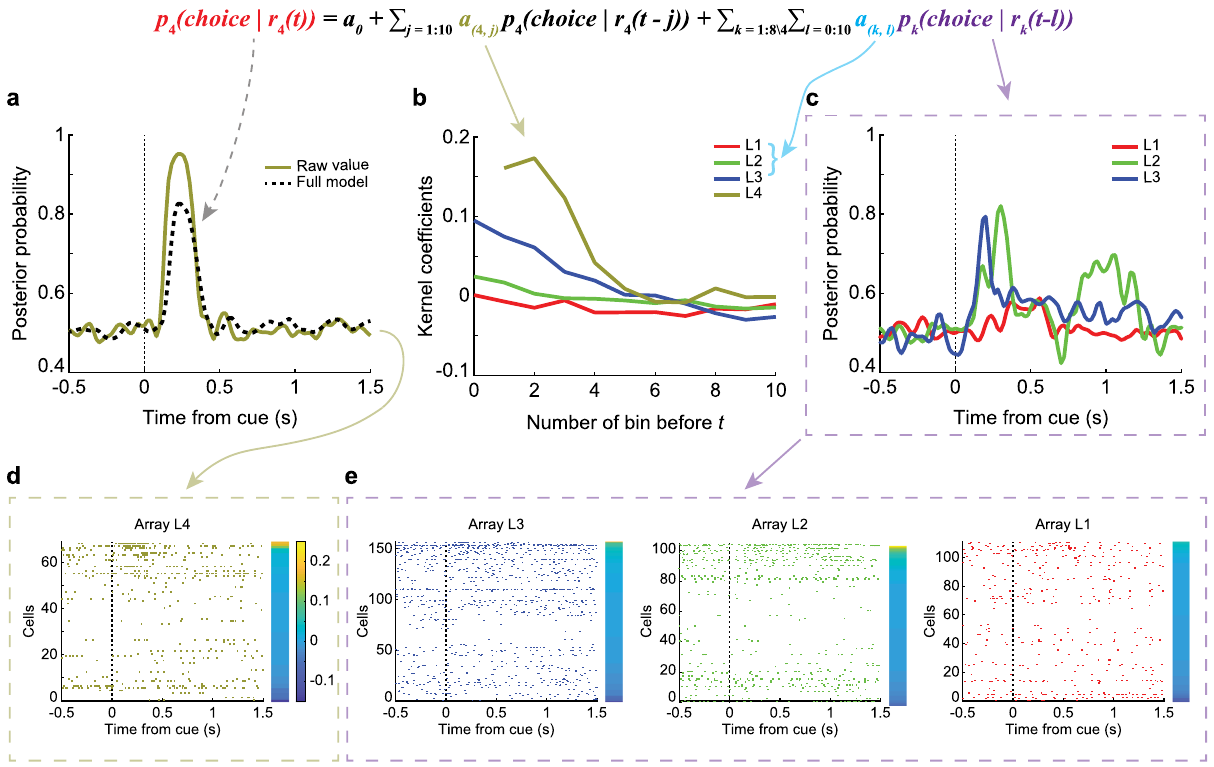
Fig. 4 Information-transfer model. A single-trial example of the information-transfer model. Predicting the decoding accuracy of action in Where blocks of array 4 in the left hemisphere (array L4) with the input from all eight arrays. a The posterior probability of the output array: the raw and the predicted value. b The kernel coef fi cients of four input arrays (arrays 1 – 4 in the left hemisphere). c The posterior probability of the input arrays (only showing arrays L1 – L3). d , e The raster of all neurons in the output ( d ) and input arrays ( e ). Ordered by the difference of distance to two choices, which was indicated by the color